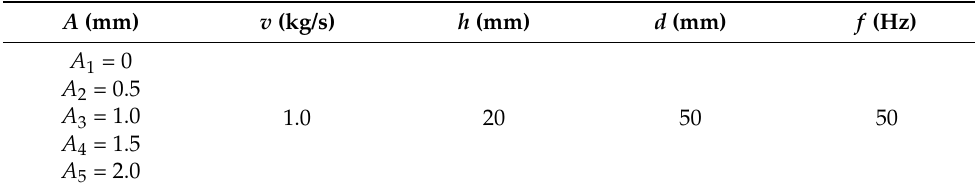
Table 7. Simulation parameters at different